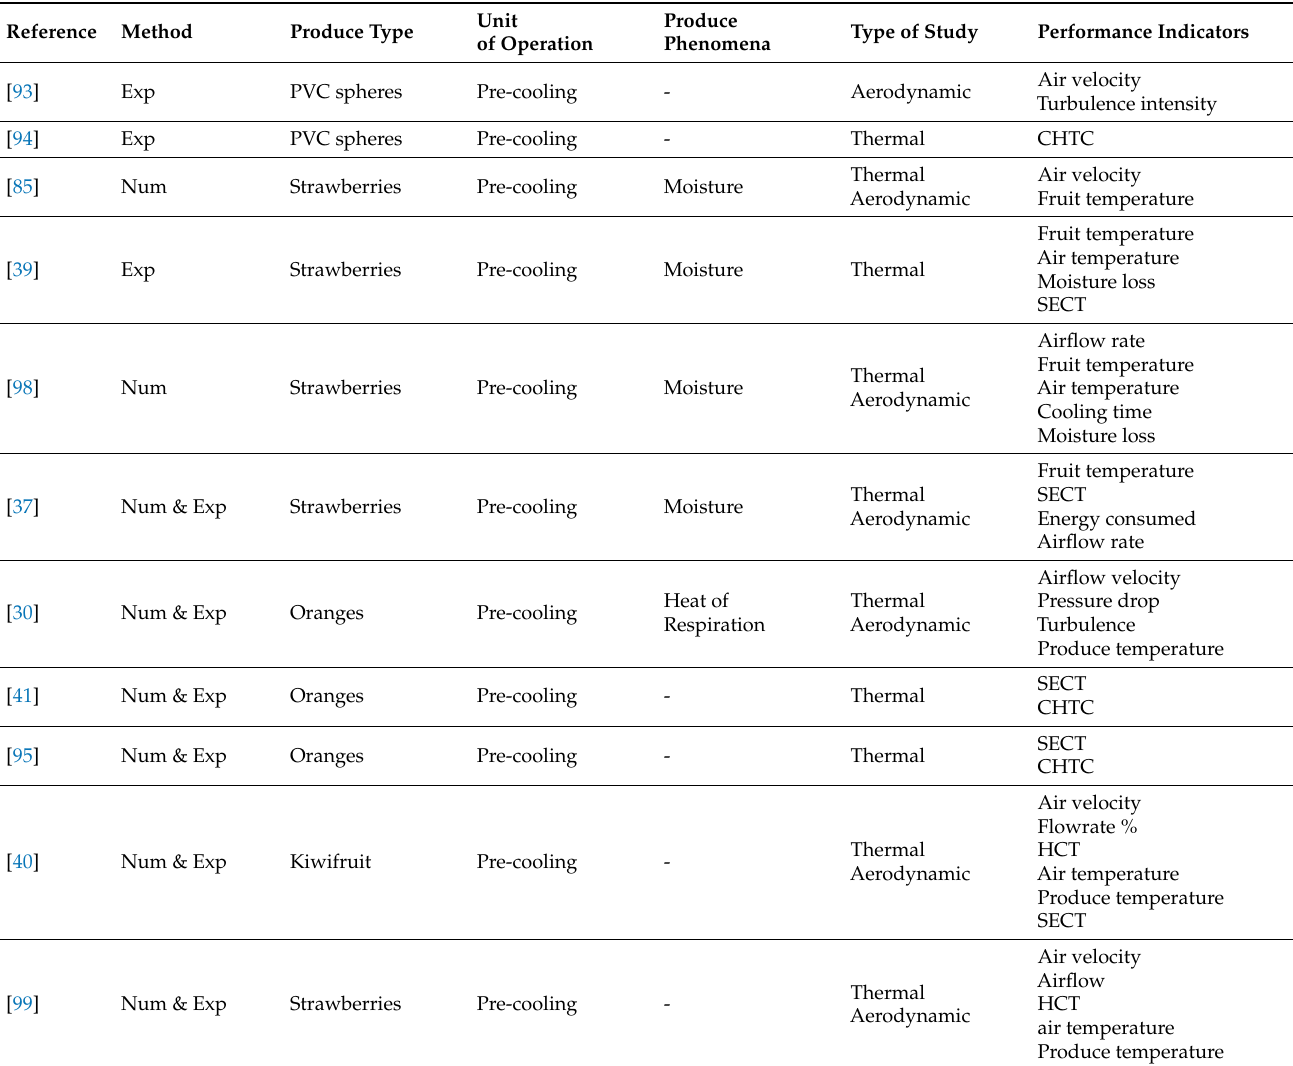
Table 4. Studies conducted to evaluate the effect of the package design on products cooling at the scale of a